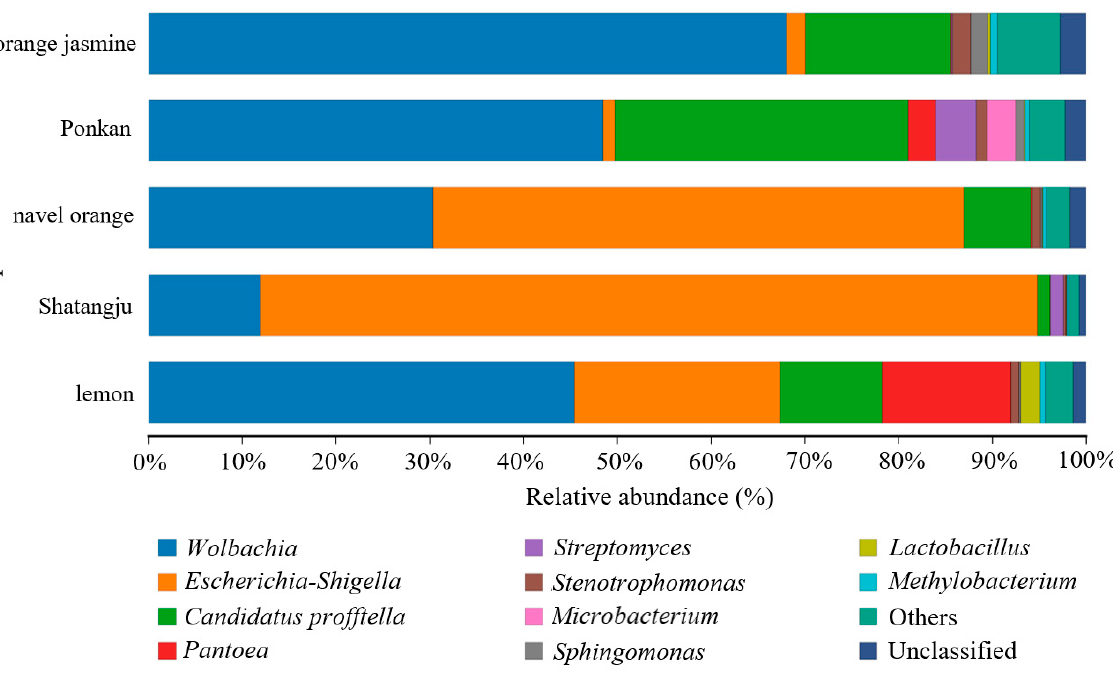
Figure 3. Relative abundance of genera in the gut of D. citri . Only the taxa within the 10 most abundant were considered.